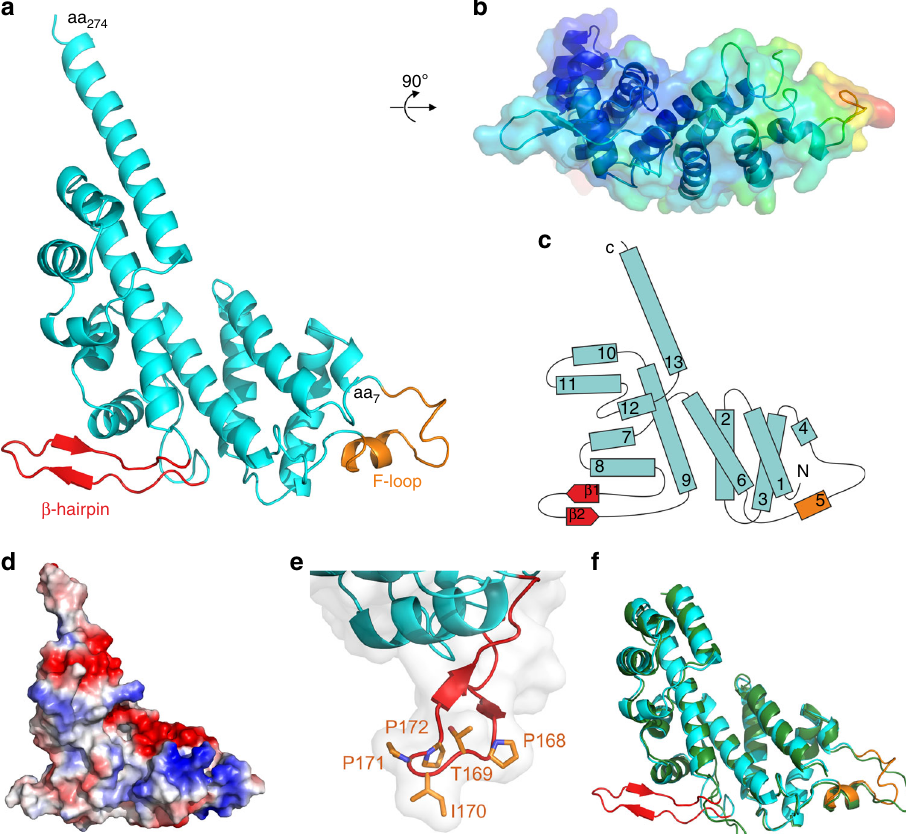
Fig. 1 The 29 kDa N-terminal domain of RidL adopts a foot-like structural fold. a 1.9 Å crystal structure of the 29 kDa N-terminal domain of RidL comprising amino acids 2 – 281. The β -hairpin (aa 160 – 180) is shown in red and the F-loop (aa 75 – 93) in orange. b Surface representation of B-factors. Structure from ( a ) depicted in a 90° rotation about a horizontal axis. c Schematic representation of the 29 kDa N-terminal domain of RidL, colored as in ( a ). d Surface charge distribution (blue for positive, red for negative, white for neutral). The structure is shown in the same orientation as in ( a ). e Detail view of the β - hairpin region. Ile 170 and adjacent residues are shown as sticks. f Structural alignment of the 29 kDa N-terminal domain of RidL (colored as in ( a )) and the corresponding Δβ -hairpin mutant (green) (aa 10 –